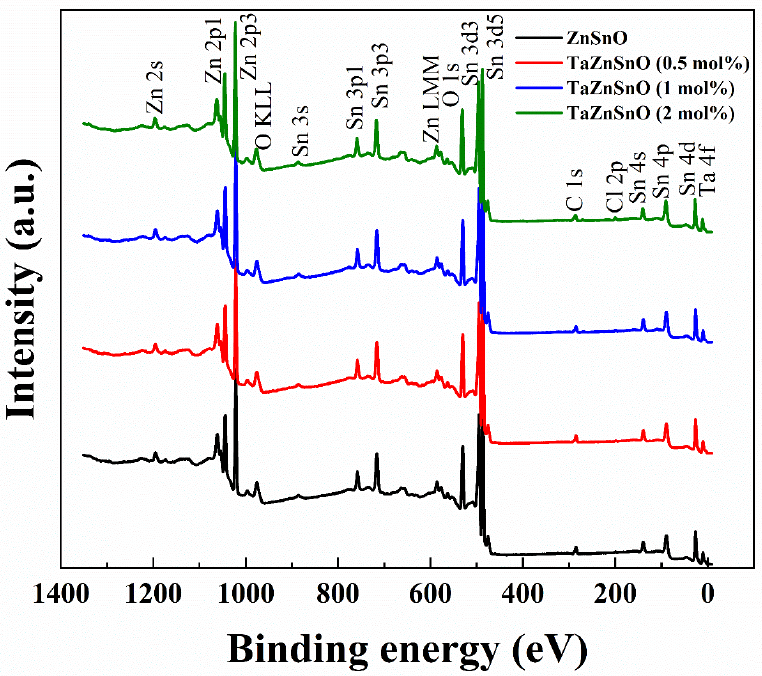
Figure 3. XPS survey spectra of the TaZnSnO thin films with different Ta 5+ doping. As shown in Figure 4a–d, all peaks were calibrated by taking the carbon C1s (284.5 eV). The XPS O1s spectra of the TaZnSnO films were fitted by three component peaks with the Gaussian distribution and approximate center frequency of 529.8 eV (O 1 ), 530.5